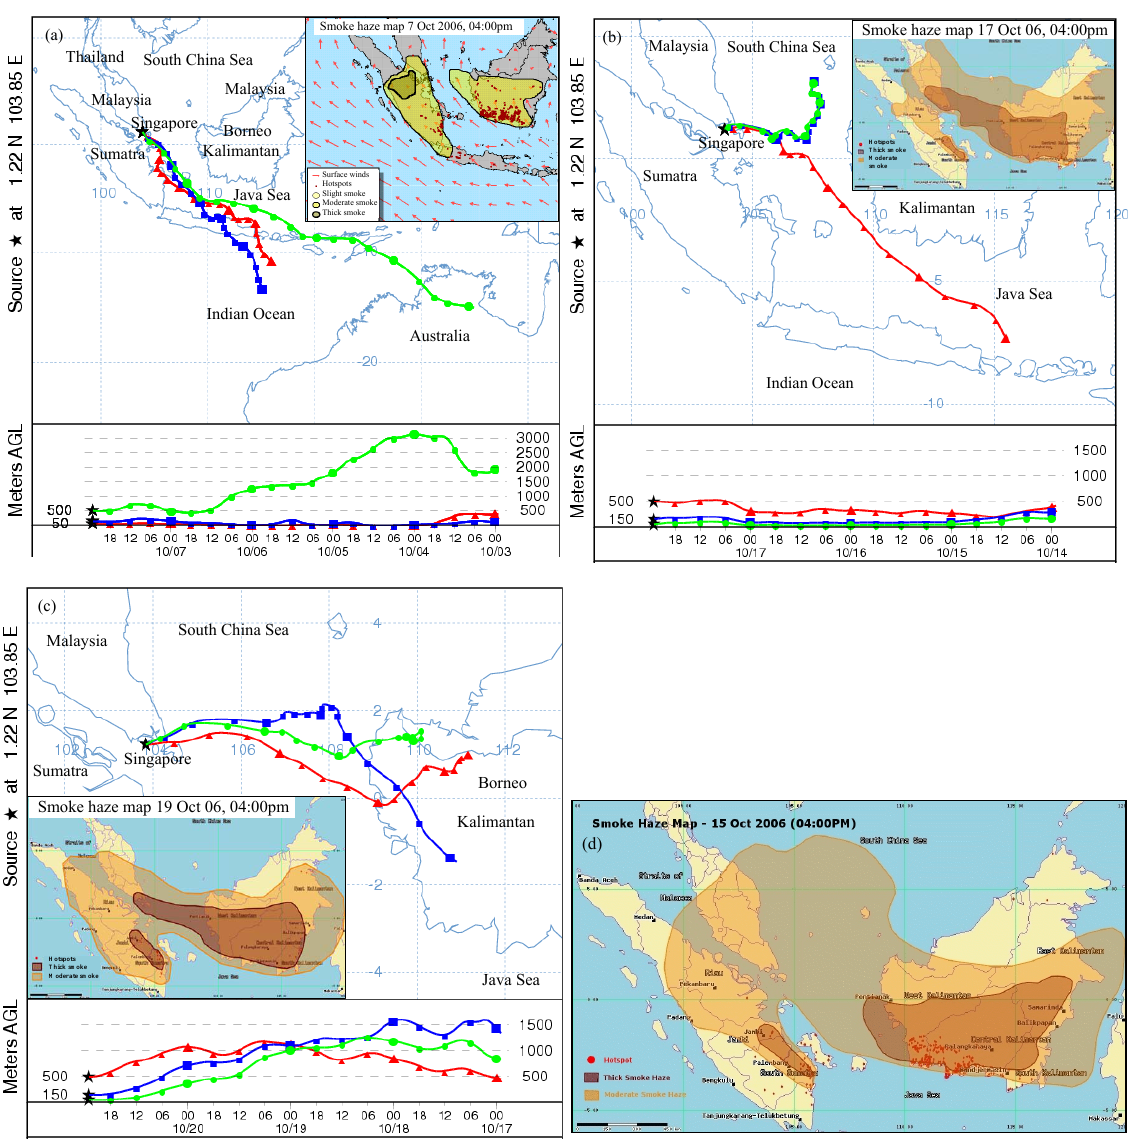
Fig. 4. Back trajectories of air masses for starting altitude of 500 m, 100 m, and 40 m above ground level (AGL) calculated from NOAA HY-846 SPLIT model for the sampling site in SJI and the extent of the smoke haze in SEA due to forest fires in Indonesia (courtesy: NEA, Singapore) (a) 847 7 October 2006; (b) 17 October 2006; (c) 20 October 2006 and (d) the representative regional smoke haze map (NEA, Singapore). 848 849